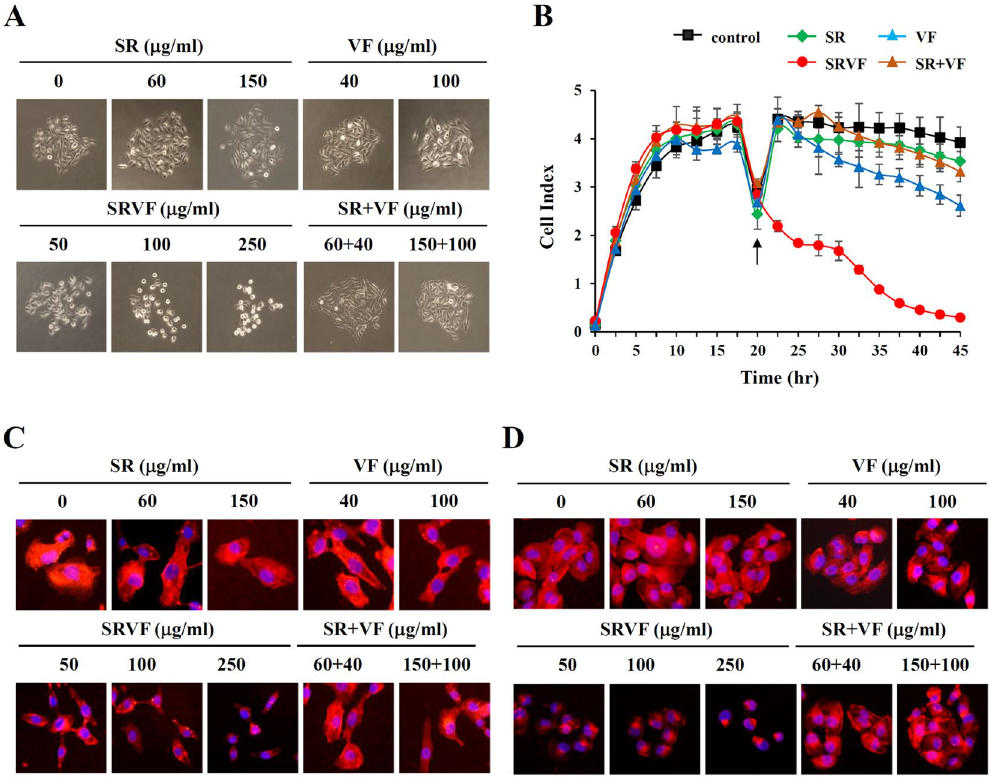
Figure 6. SRVF reduces cell adhesion and F-actin intensity in cancer cells. ( A ) Cancer cell colonies were treated with the indicated concentrations of SR, VF, or SRVF for 24 h and the morphological changes were observed under an inverted microscope. ( B ) Cells were seeded onto the E-Plate 16 and incubated in culture medium for 20 h. After replacing with fresh medium containing SR, VF, or SRVF, cells were monitored for electrical impedance for an additional 24 h. Data are expressed as the mean ± SD of triplicate samples. ( C , D ) HT1080 ( C ) and MDA-MB231 ( D ) cells were seeded onto the coverslips and treated with the indicated concentrations of SR, VF, or SRVF for 6 h and stained with TRITC-conjugated phalloidin. Nuclei were counterstained with DAPI and visualized under a fluorescence microscope. Data are representative of three independent